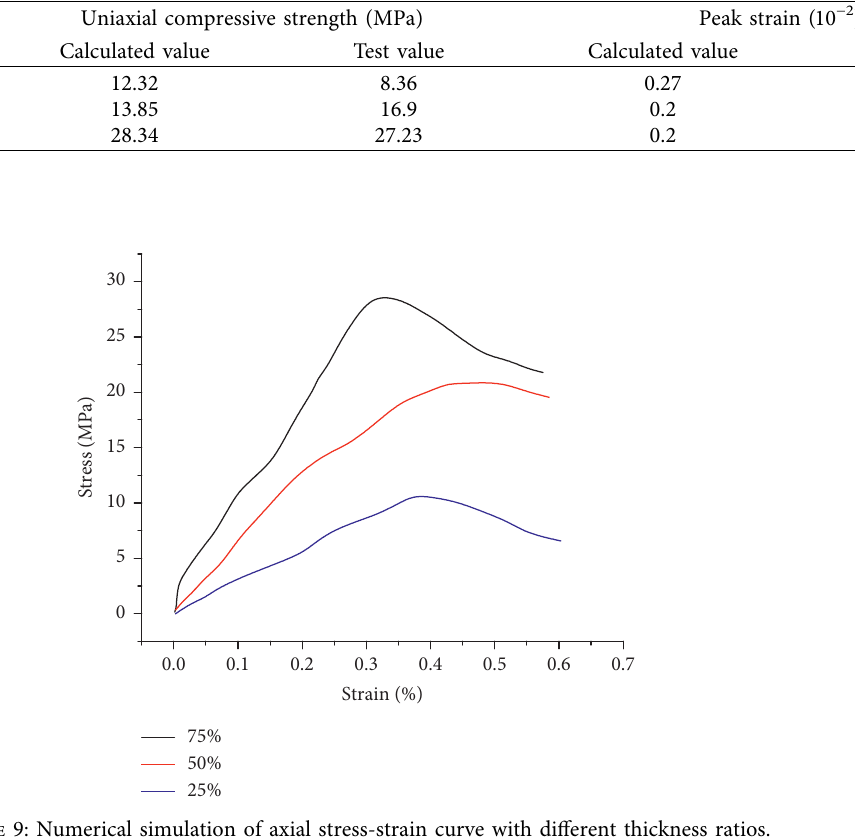
Table 3: Comparison of the results of uniaxial compression between numerical calculation and physical simulation test.